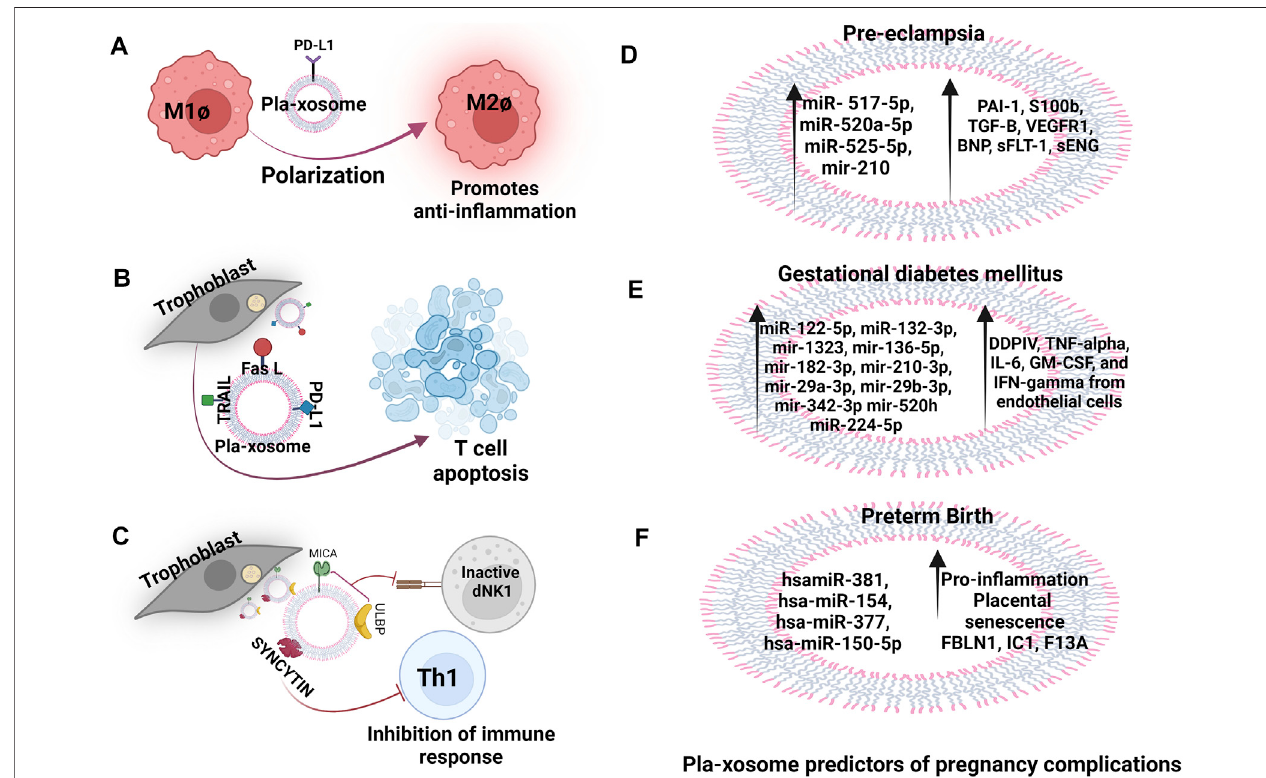
FIGURE3| Pla-xosomesinheathy, complicated pregnanciesandadverseoutcomes. (A) Pla-xosome(PD-L1+)causesM1ØtoM2Øpolarizationtoincreaseanti- in fl ammation (B) Pla-xosomes (Fas L + TRAIL + PD-L1+) cause T cell apoptosis for regulated immunosuppression (C) Pla-xosomes (ULBP + MICA + Syncytin+) cause inhibition of innate and adaptive immune response to support restructuring of materno-fetal interface (D) Increased expression of pla-xosomal miR- 517-5p, miR-520a- 5p, miR-525-5p, and miR- 210 and the proteins PAI-1, S100b, TGF-B, VEGFR1, BNP, sFLT-1, sENG as predictors (E) miR-122-5p, miR-132-3p, mir-1323, mir- 136-5p, mir-182-3p, mir-210-3p, mir-29a-3p, mir-29b-3p, mir-342-3p and mir-520h along with proteins like DDPIV, GLP-1, tumor-necrosis factor-alpha (TNF- α ), IL-6, GM-CSF, and IFN-gamma in GDM reported to be predictors of the disease (F) hsamiR-381, hsa-miR-154, hsa-miR-377, and hsa-miR-150-5p and proteins FBLN1, IC1, F13A are associated with preterm labour that causes increased placental senescence and in fl ammation.